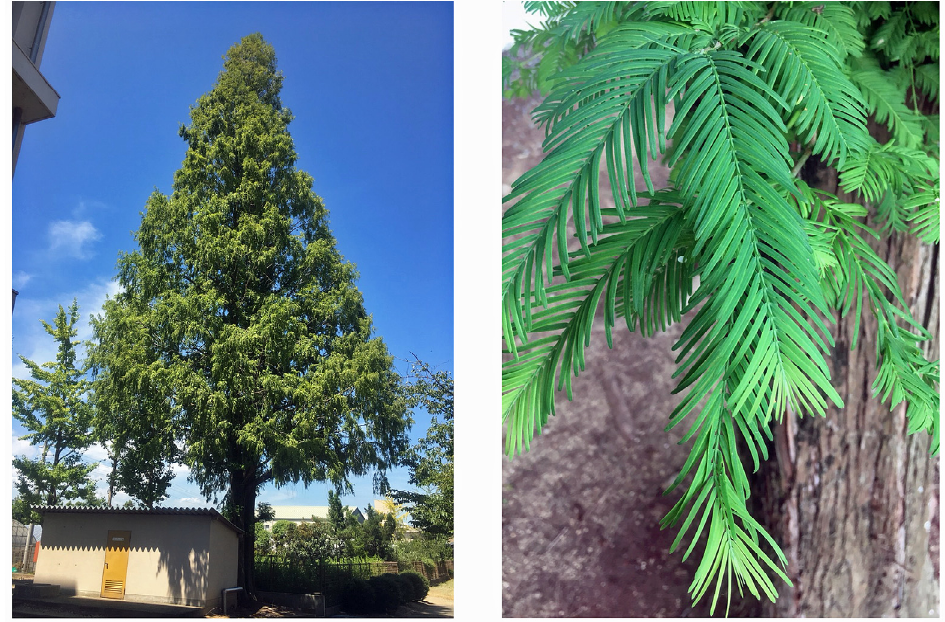
Figure 1. M. glyptostroboides .